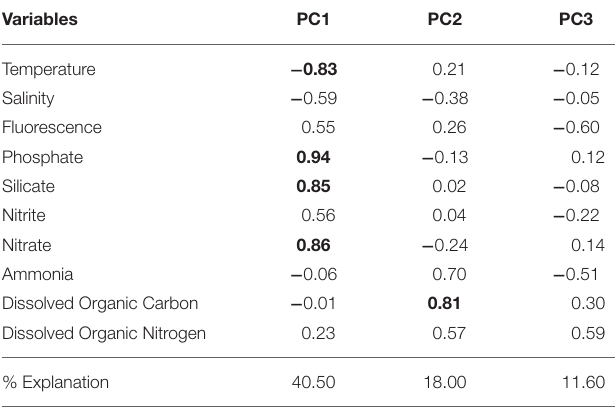
TABLE 1 | Results of principal component analysis (PCA) using environmental variables (temperature, salinity, fluorescence, phosphate, silicate, nitrite, nitrate, ammonia, dissolved organic carbon, and dissolved organic nitrogen). Principal component loadings > 0.70 are shown in